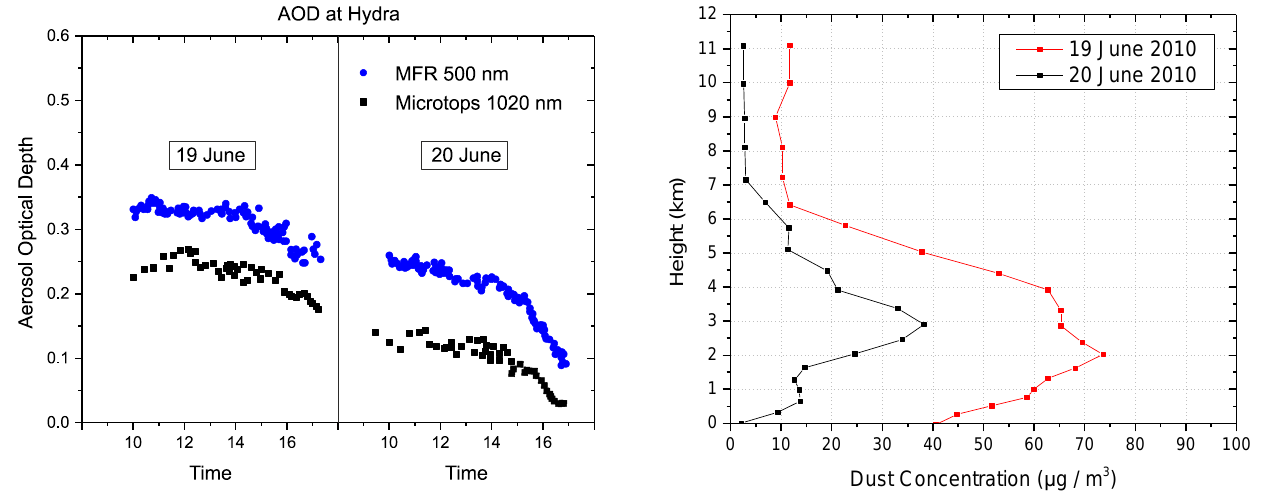
Fig. 8. Vertical distribution of the Saharan dust concentration load- ing (µgm − 3 ) for the 19 and 20 June 2010, as simulated by the BSC/DREAM model